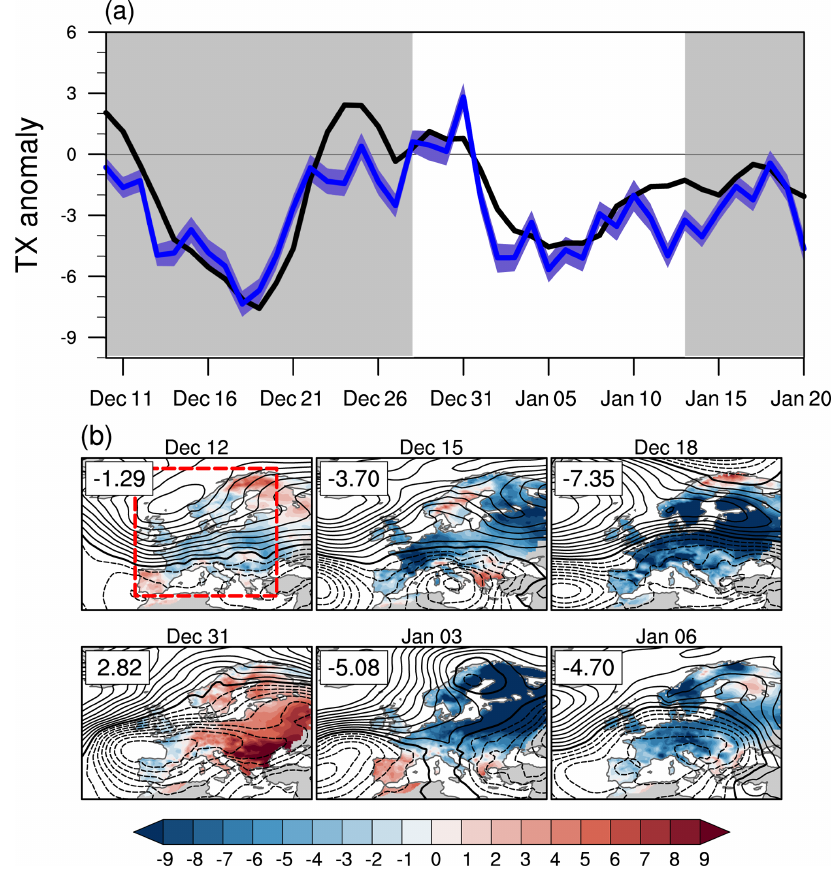
Figure 2. (a) Time evolution of EOBS daily maximum temperature ( ◦ C) anomaly averaged over the European domain (box with red dashed line in b ). The covered period is from 10 December 2009 until 20 January 2010. The thick black line represents the total TX anomaly. The thick blue line shows the contribution of the dynamic component, and the blue shading indicates the 95% confidence interval of the reconstruction based on bootstrapping (see Sect. 2.2). The chosen period for the 2-week cold spell is defined by the white background. (b) Daily maps of SLP anomaly (hPa, black line contours with contour interval of 1hPa) and of the dynamic component contribution ( ◦ C, shading) to the total TX anomaly. The black thick contour line indicates the zero SLP anomaly, and dashed contour lines indicate negative SLP anomalies. Numbers in the upper left corner indicate the region-averaged contribution of the dynamic component to the total TX